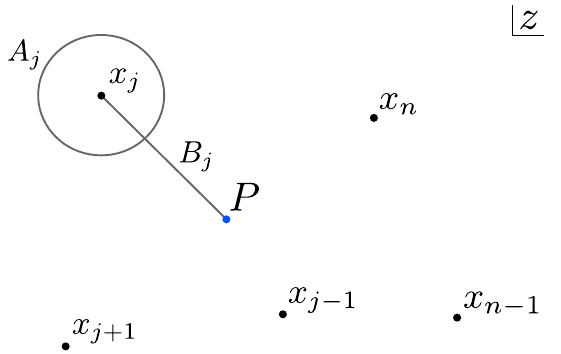
Figure 1 . The A - and B -cycles of the n punctured z -plane. The A -cycles go around the punctures, whereas the B -cycles go from an intersection to a reference point P , indicated in